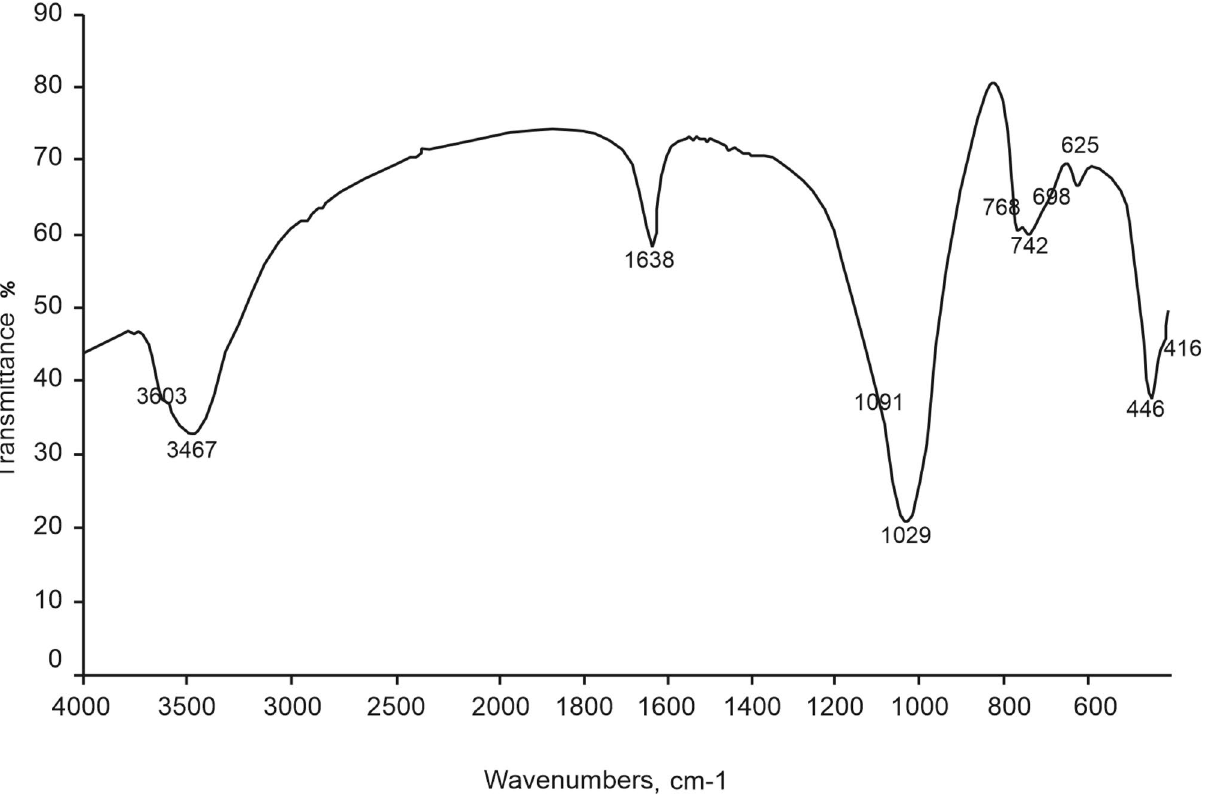
Figure 4. IR spectrum of the analcime at 10 h (170 °C).